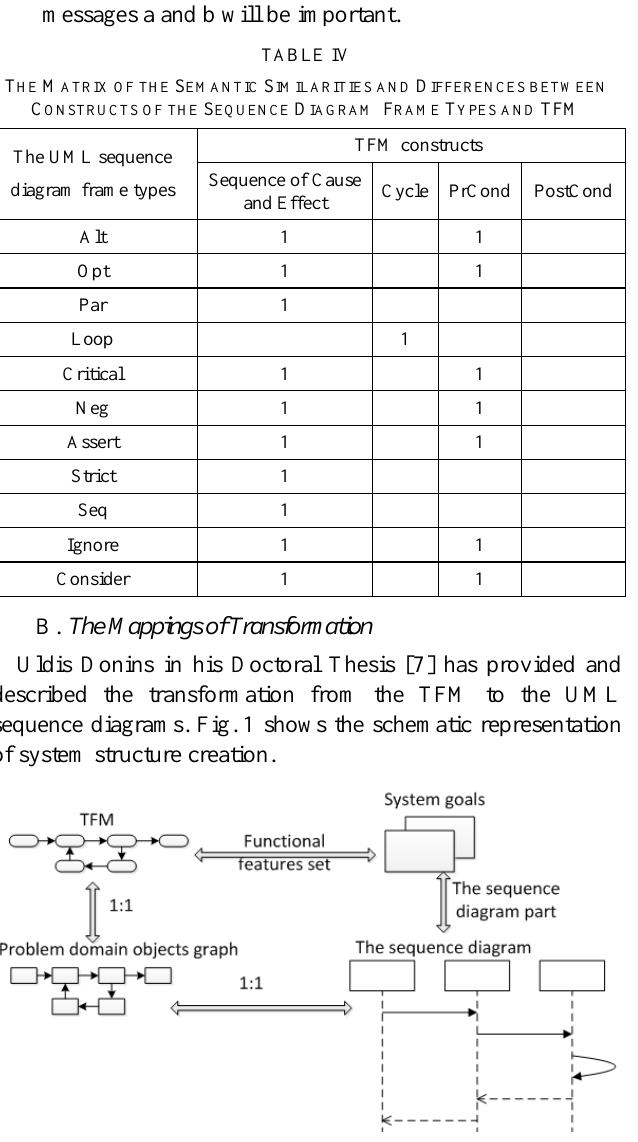
Fig. 1. The schema of software system structure creation. The transformation from the TFM to the problem domain object graph is one-to-one, that means that all associations and the model structure need to be the same. The